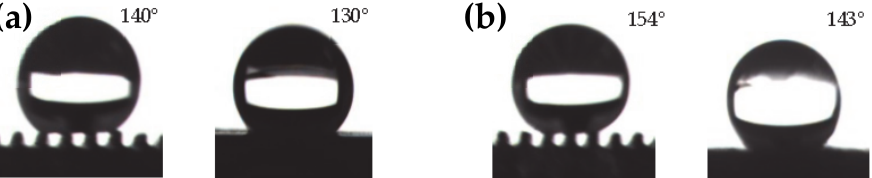
Figure 8. Effect of low surface energy modification on surface hydrophobicity. ( a ) CA of unmodified titanium alloy with macro-micro composite structure. ( b ) Contact angle of modified titanium alloy with macro-micro-composite structure.